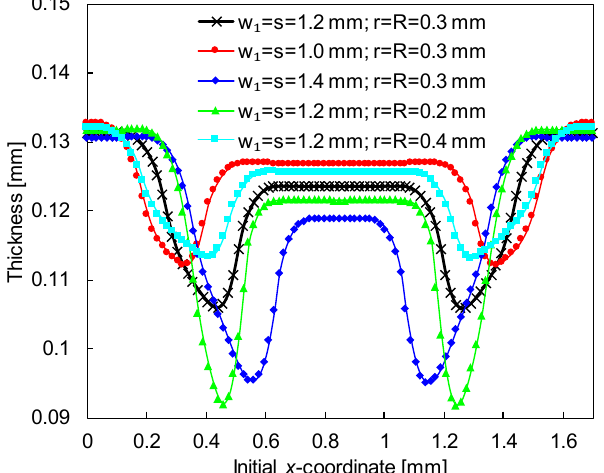
Figure 11. Thickness distribution in half-channel for three values of channel/rib width and three values of punch/die fillet radius ( h = 1.0 mm).